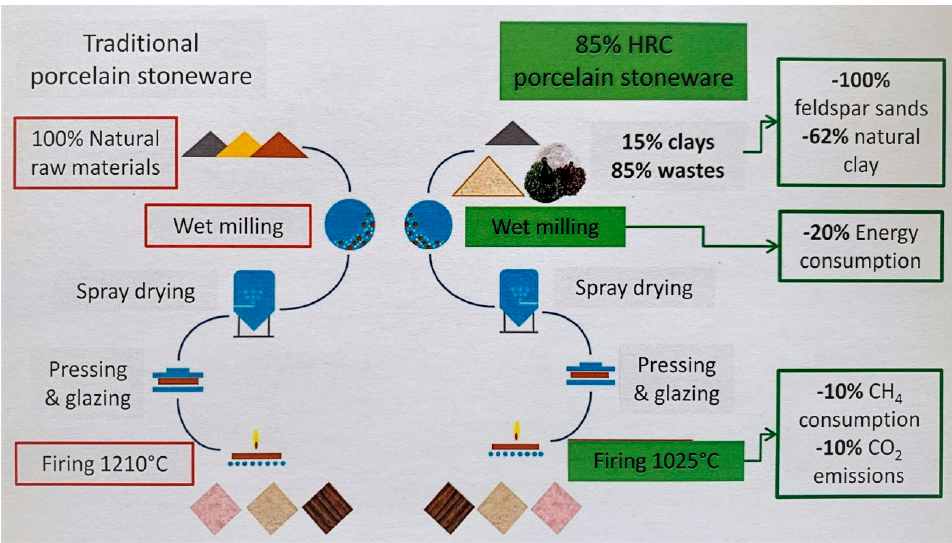
Figure 6. Comparison of the industrial production process steps and envisaged savings.